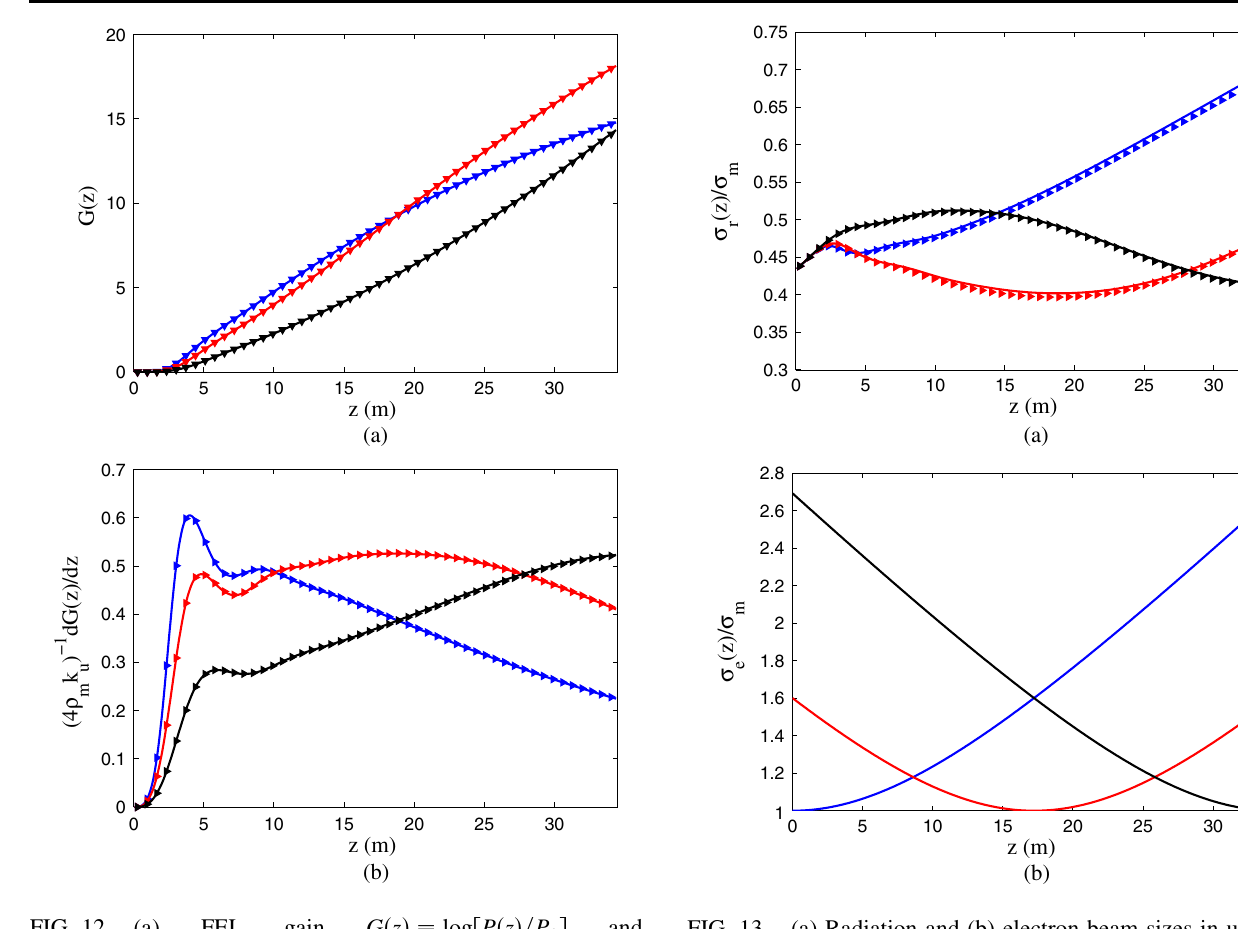
(cid:2) and FIG. 13. (a) Radiation and (b) electron beam sizes in units of 0 Þ (cid:1) 1 dG ð z Þ =dz k (cid:9) for three different unfocused beams. The legend is the same m u m ¼ (cid:9)=(cid:9) 0 ¼ 13 : 78m and z ¼ as in Fig. 12. e e